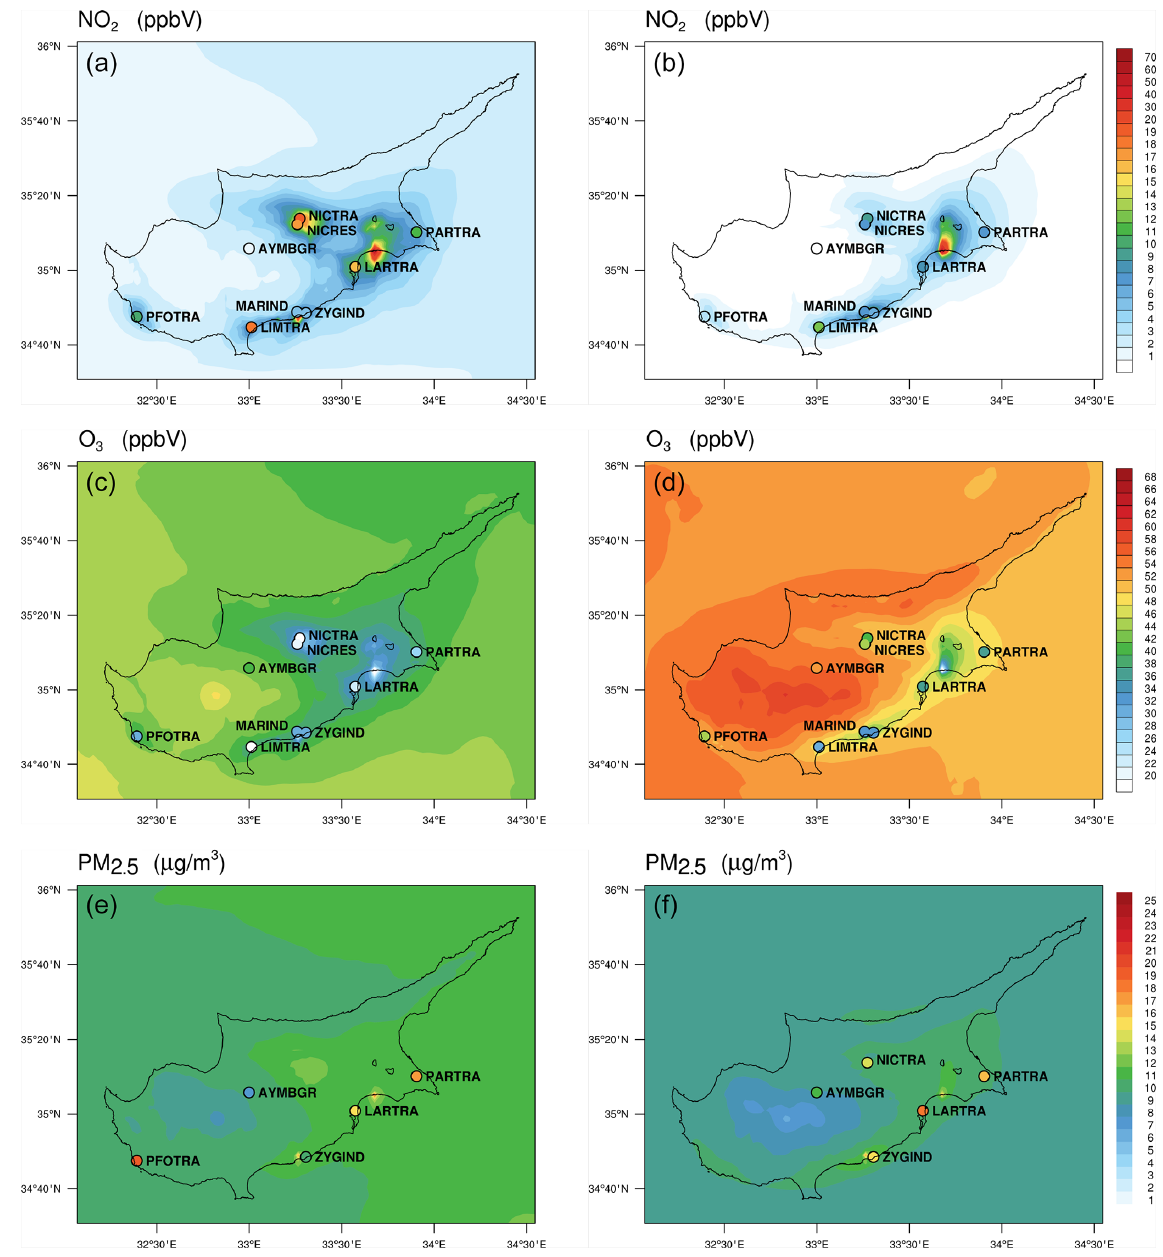
Figure 3. Average NO 2 (a, b) and O 3 (c, d) mixing ratios, and PM 2 . 5 (e, f) concentrations from the first day of the WRF-Chem forecast during winter (a, c, e) and summer (b, d, f) . The filled dots indicate the observed